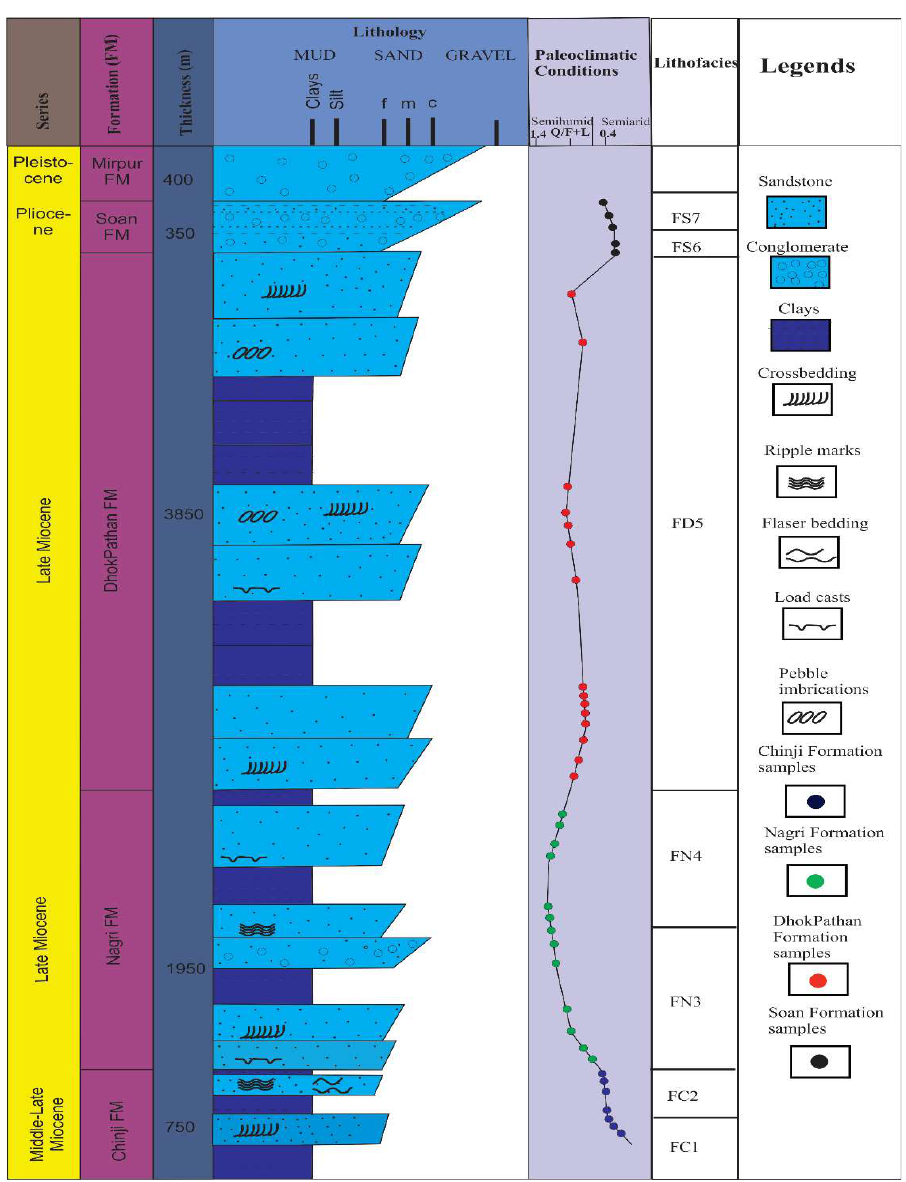
Figure 5. Log showing the lithology of Dadyal to Sehnsa area of Mirpur division. The FC1 and FC2 facies assemblages are present in the Chinji Formation. The FC1 type facie exists at the base of the Chinji Formation and is characterized by thick stratified ash grey fine-grained sandstone (St, 0.4 to 1.2 m thick) intercalated with mudstone (Fm, 0.8 to 1.7 m thick) and occasionally thin mudstone beds (Fl) (Figure 4a). The sandstone beds have been eroded marginally from the bottom (Figure 4a). Because of the presence of